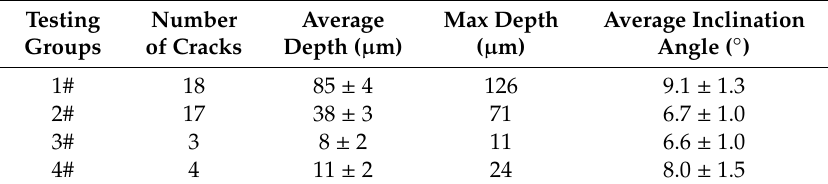
Table 5. Statistics of crack depth and angle.